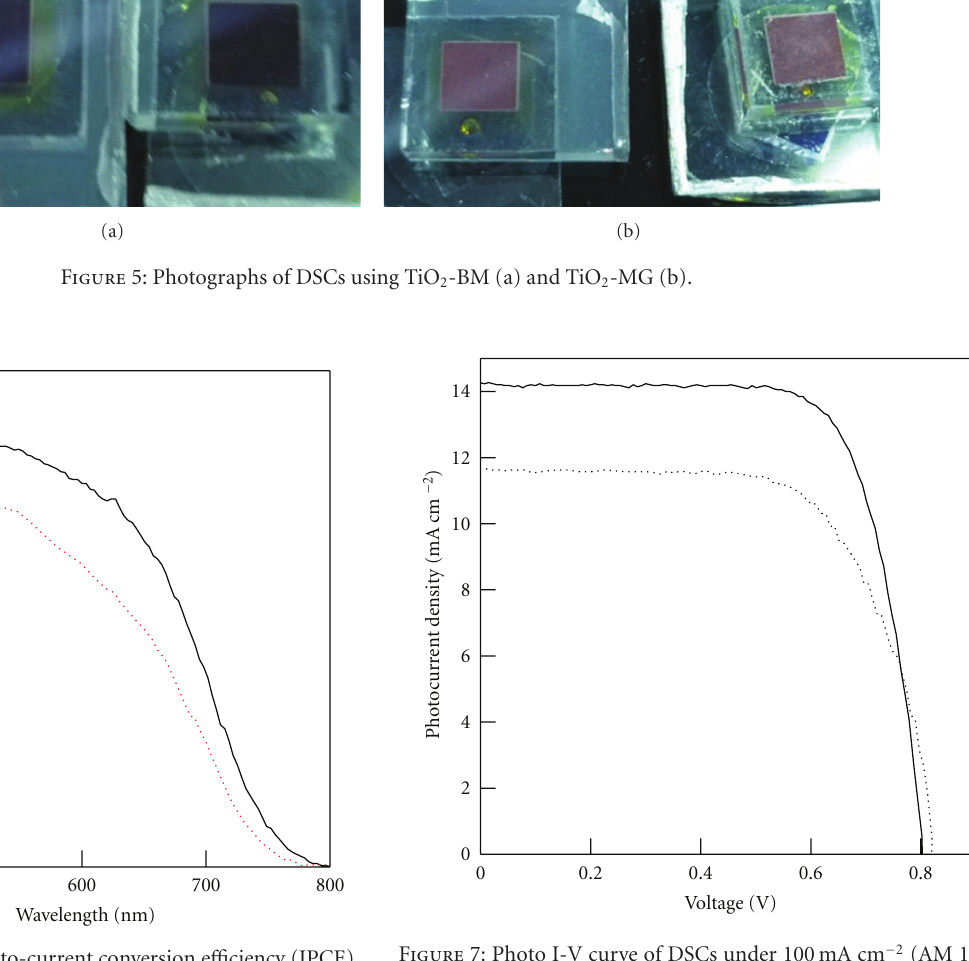
Figure 6: Incident photon-to-current conversion e ffi ciency (IPCE) spectra of DSCs: TiO 2 -BM paste (solid line), TiO 2 -MG paste (dotted line).